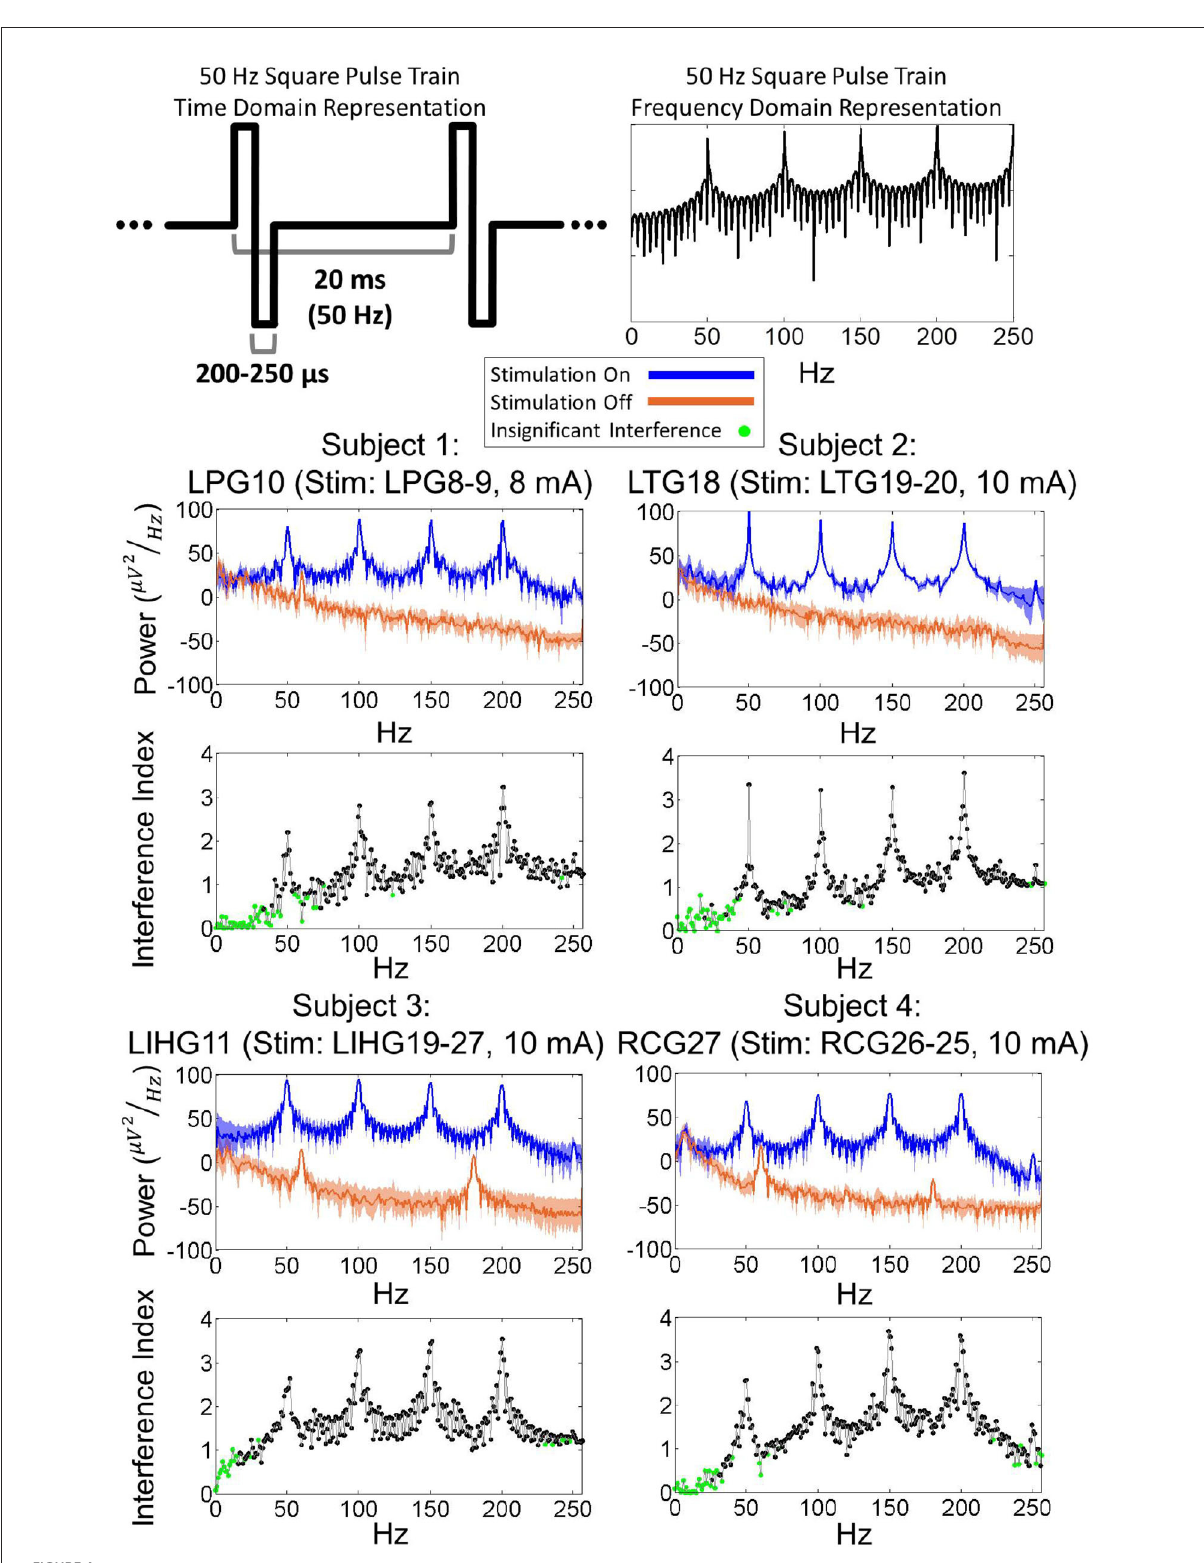
FIGURE4 (Top) Time domain and frequency domain representations of a 50 Hz square pulse train. (Bottom) Power spectra of ECoG signals during 50 Hz biphasic square pulse stimulation for worst-case electrodes from each subject. The power distribution of ECoG signals, with peaks present at 50, 100, 150, 200 Hz, resembles the power distribution of a 50 Hz square pulse train. Interference index and Kolmogorov-Smirnoff testing ( p = 0.01) show that a majority of significantly impacted frequencies are above the 50 Hz stimulation pulse